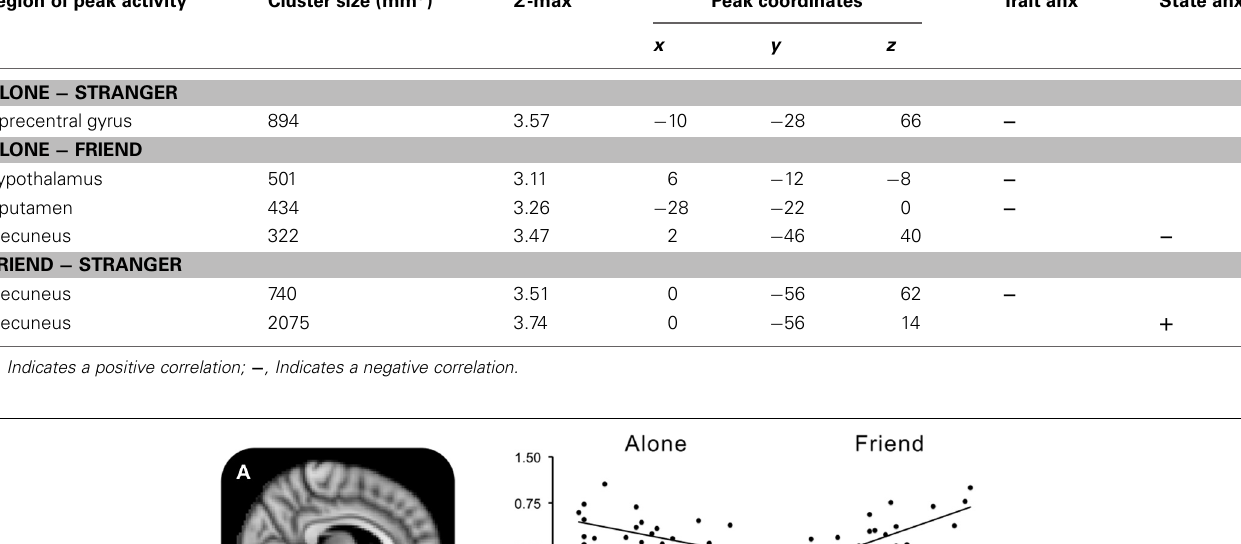
Table 2 | Interactions between handholding conditions and trait/state anxiety levels. Region of peak activity